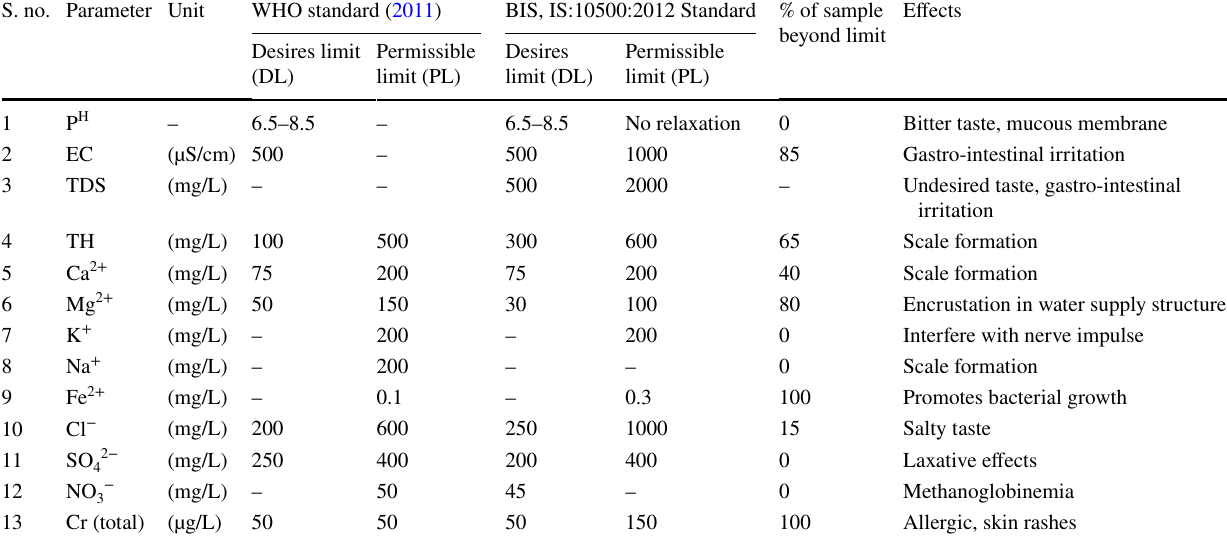
Table 2 Different guideline values for the drinking water with the percentage of samples beyond permissible limit (PL) and the resulting health implications (WHO 2011) S. no. Parameter Unit